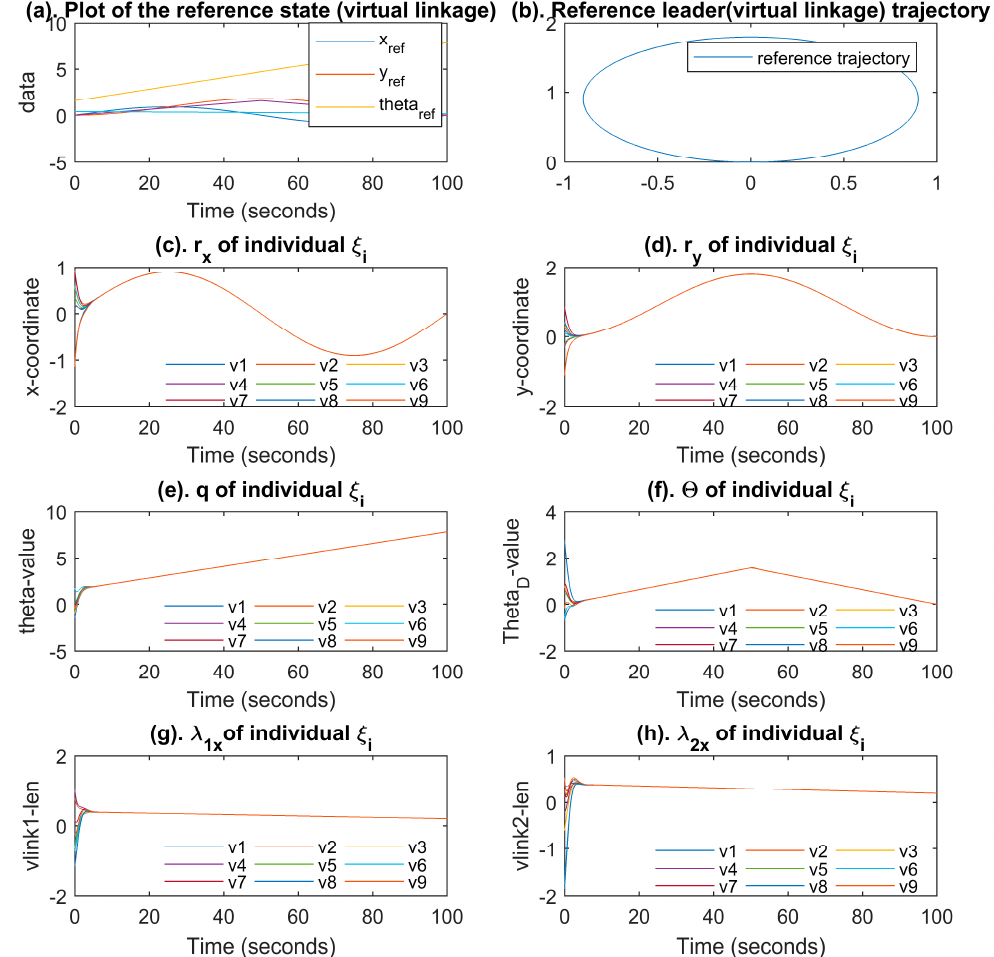
Figure 11. Simulation results formation reconfiguration using virtual linkage.